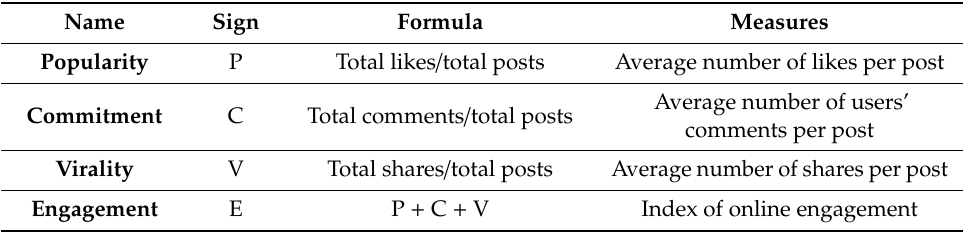
Table 2. Metrics used to measure user online